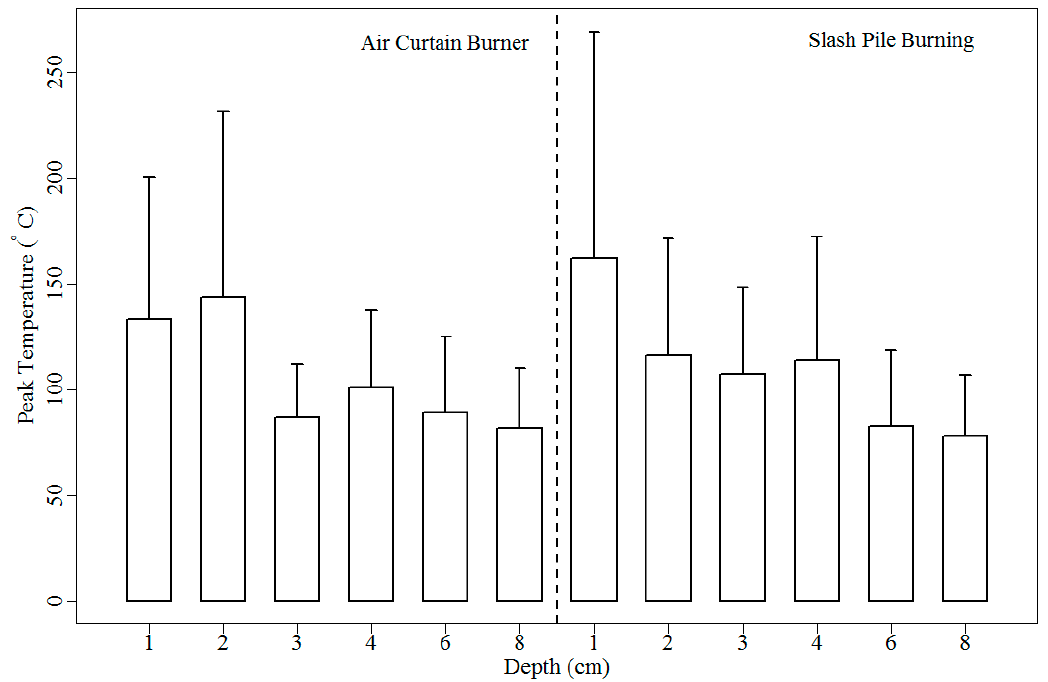
Figure 2. Mean peak temperature by soil depth. Error bars represent one standard deviation.